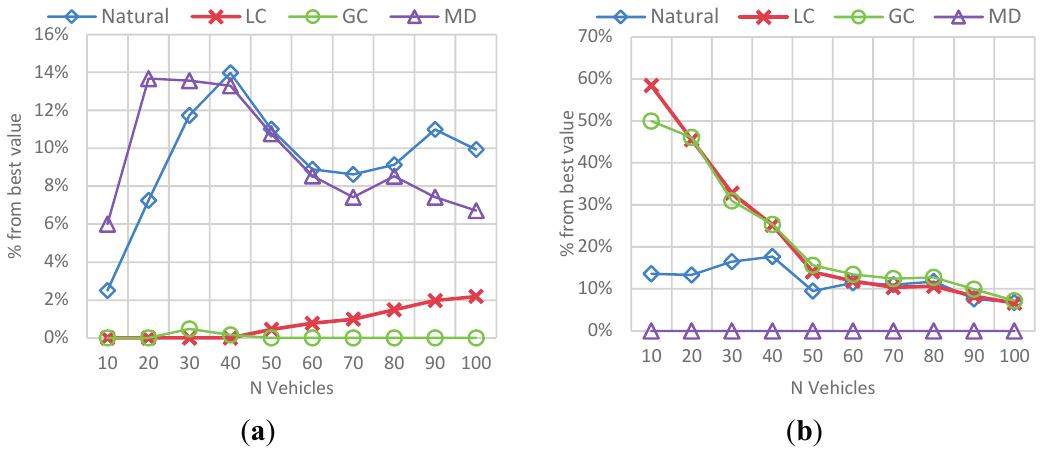
Figure 21. Best value comparison for route efficiency and trip distance in the N-vehicles scenario. ( a ) Percentage comparison against the best value obtained for efficiency; ( b ) Percentage comparison against the best value obtained for trip